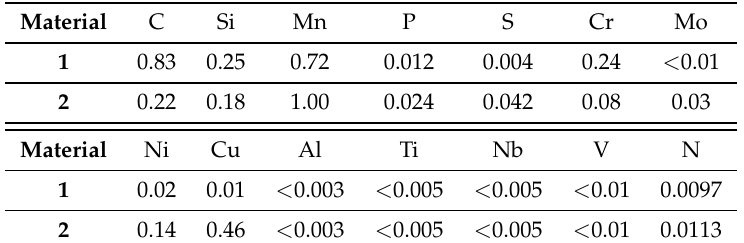
Table 1. Chemical composition of both materials in %.